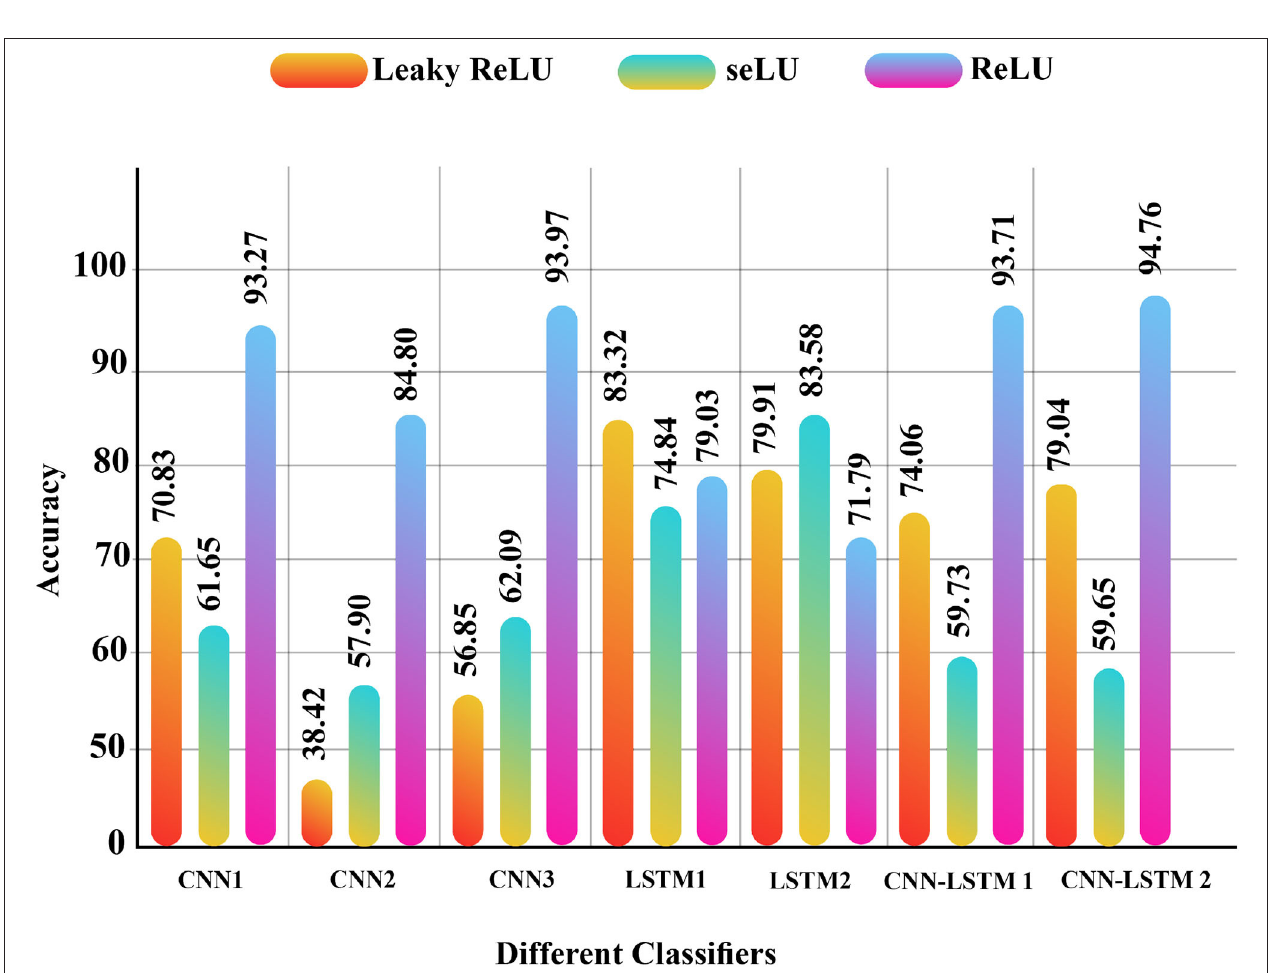
functions and z -score and z -score + L2 normalization methods are drawn in Figure 6 . Firstly, on the left of Figure 6 , the